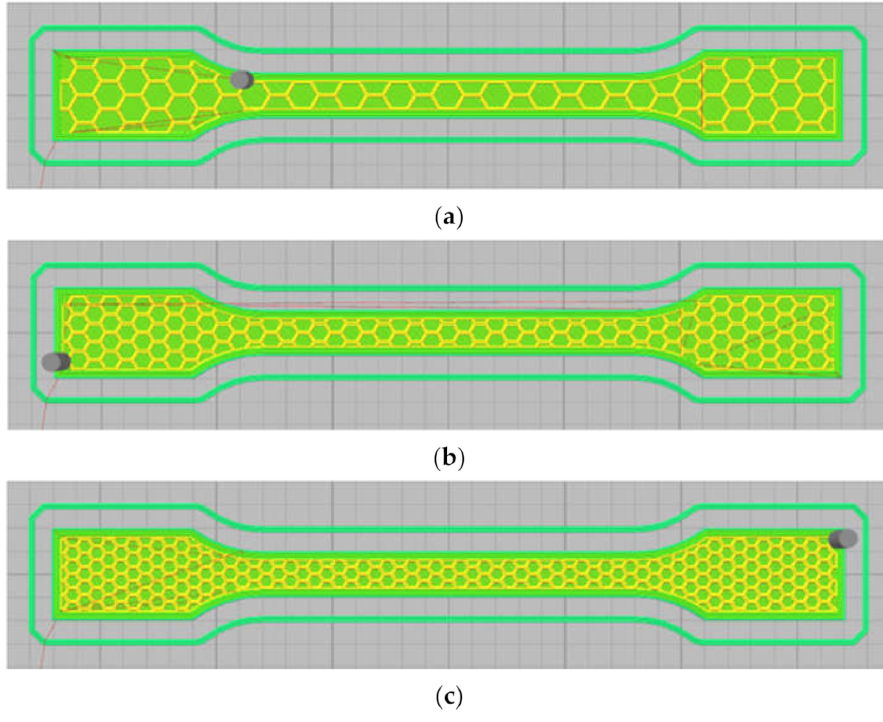
Figure 4. Honeycomb internal pattern at ( a ) 20%, ( b ) 30%, and ( c ) 40%.